Question: In one sentence, what is this figure communicating?
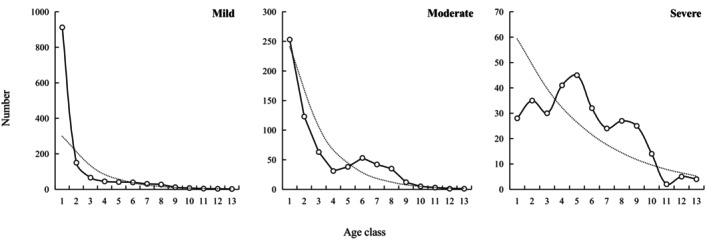
Answer: Survival curve of populations.